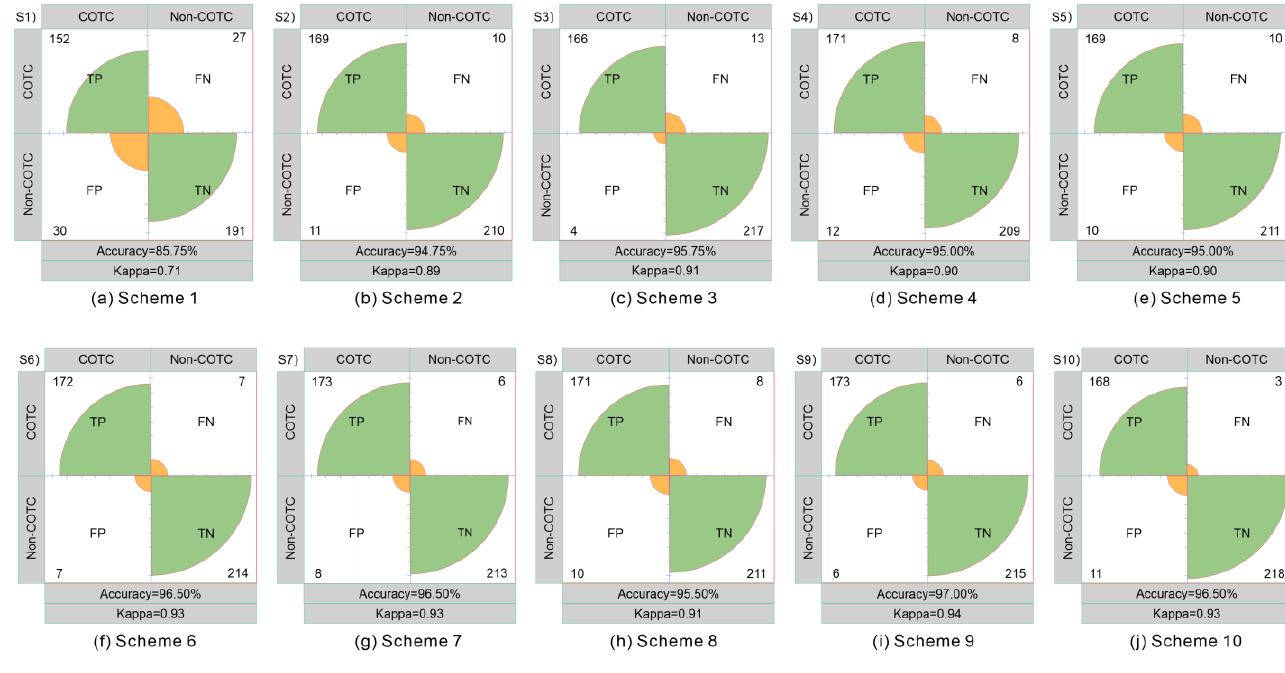
Figure 9. Evaluation of extraction accuracy of different feature combination schemes using OBIA-RF. TP and TN indicate the number of test points where the ground objects are correctly classified as COTC and non-COTC, respectively. FP and FN indicate the number of test points where the ground objects are incorrectly classified as COTC and non-COTC, respectively.